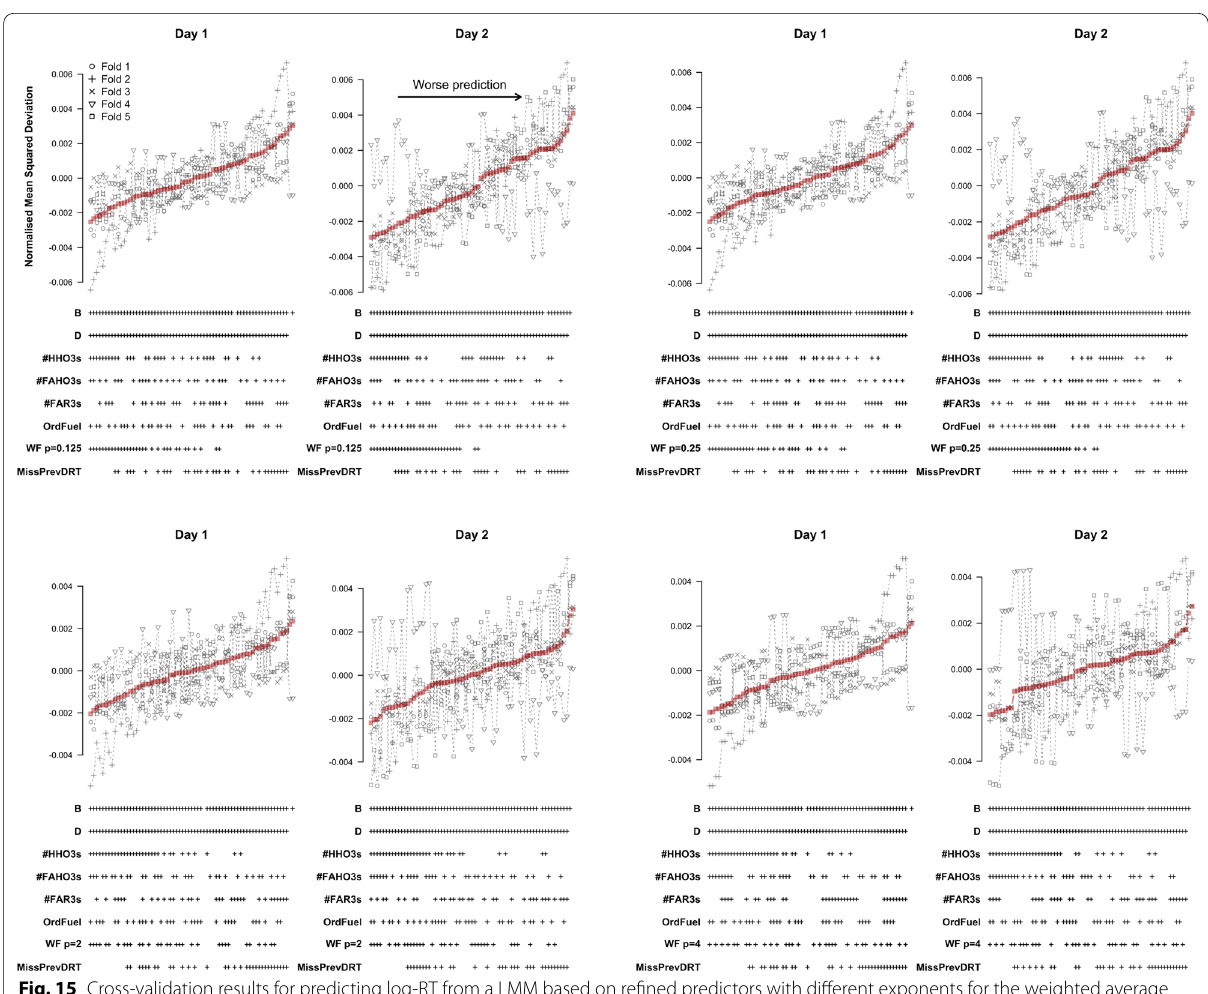
Fig. 15 Cross-validation results for predicting log-RT from a LMM based on refined predictors with different exponents for the weighted average fuel-load predictor. Note that in order to make comparison easy the results in the top right panel repeat those in Fig.